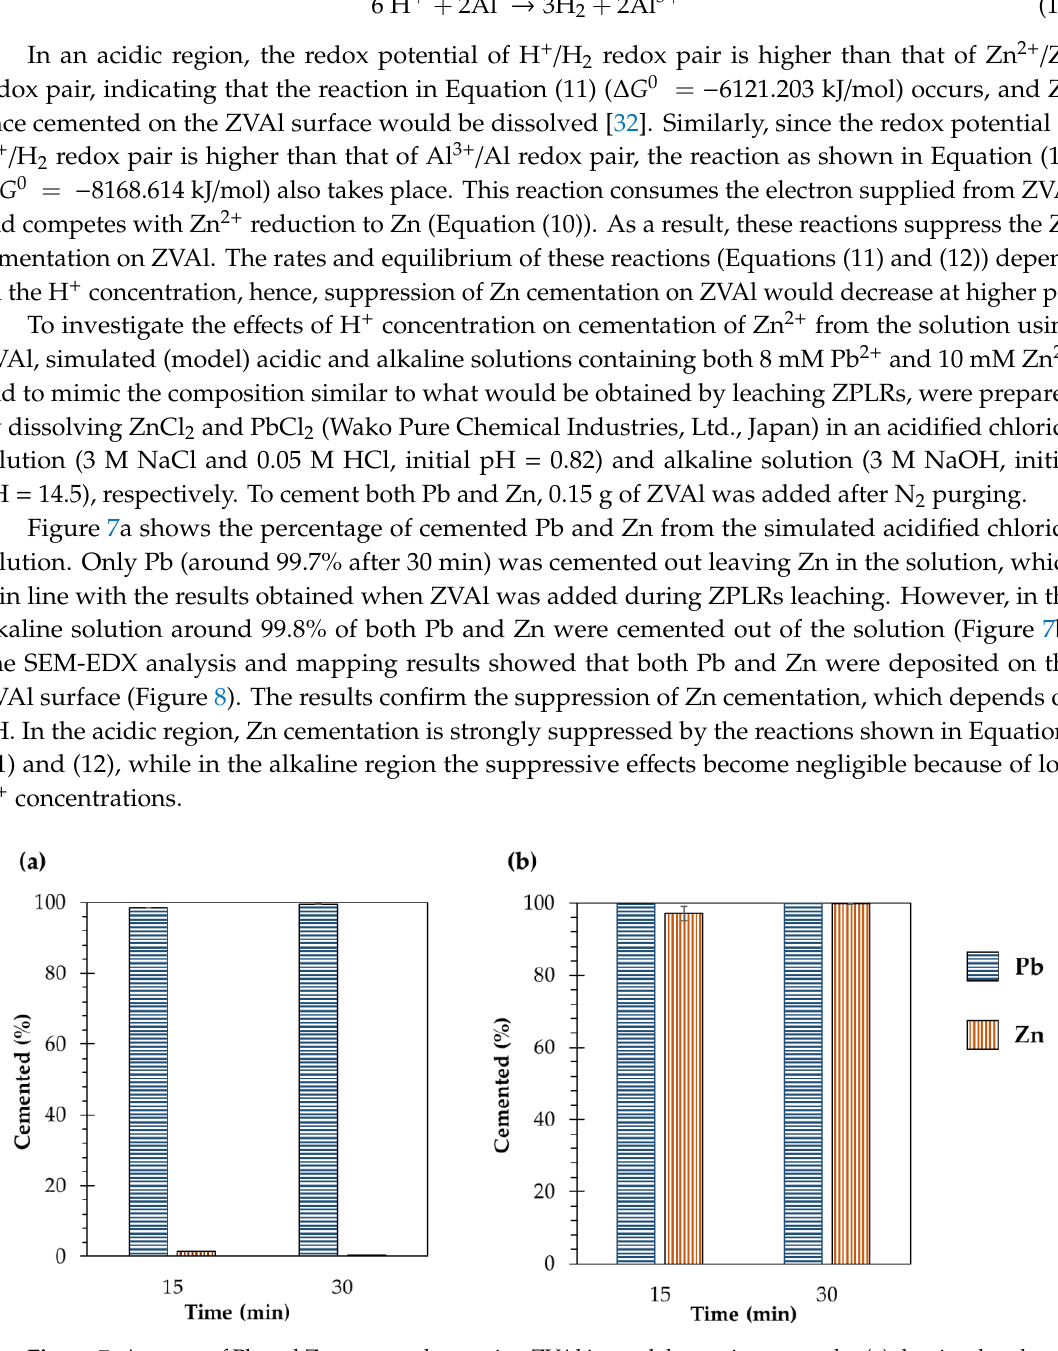
Figure 8. SEM-EDX of cementation product of Pb and Zn by ZVAl from the alkaline simulated solution: ( a ) SEM image, EDX elemental mapping of ( b ) Pb, ( c ) Al, ( d ) Zn, and ( e ) EDX spectra. 3.2. Effects of Solution Composition on Pb and Zn Removal from Zinc Plant Leach Residues Lead and Zn removal from ZPLRs was evaluated for different solution compositions and compared with the removal efficiencies when ZPLRs was leached with and without ZVAl addition. When ZVAl was added during ZPLRs leaching, Pb was extracted into a leaching solution and concurrently cemented and agglomerated. The Pb distribution among the solution (i.e., extracted but uncemented Pb), +150 μm particles (i.e., cementation and agglomerated product), and −150 μm particles (unextracted Pb in residues). Since the amount of Pb that remained in the solution was negligible (in most cases below 0.1 mg/L), Pb removal in a case when ZVAl was added during ZPLRs leaching is referred to as Pb that was extracted, cemented, and separated as +150 μm particles. However, in the case when ZPLRs were leached without the addition of ZVAl, Pb removal is referred to as the Pb that was extracted into a leaching solution. The same definition was also applied to Zn removal with and without ZVAl addition since it was not cemented from the leaching solution, as discussed previously. Lead removal when ZPLRs were leached without the addition of ZVAl increased with increasing both HCl and NaCl concentrations, as shown in Figure 9. Pb removal steadily increased from around 0% to 28%, 0.5% to 58%, and 0.5% to 72% for 0.01, 0.05, and 0.1 M HCl, respectively, when NaCl increased from 0 to 3 M, respectively. Lead dissolution from anglesite (PbSO 4 ) depends on (1) Cl −